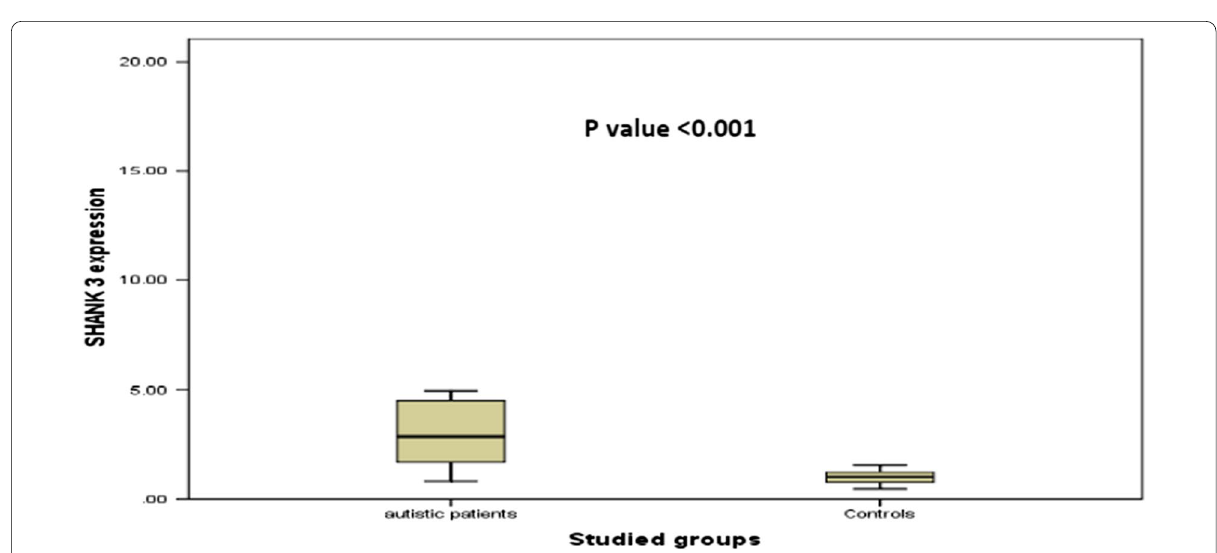
Fig. 6 Shank-3 expression among the studied